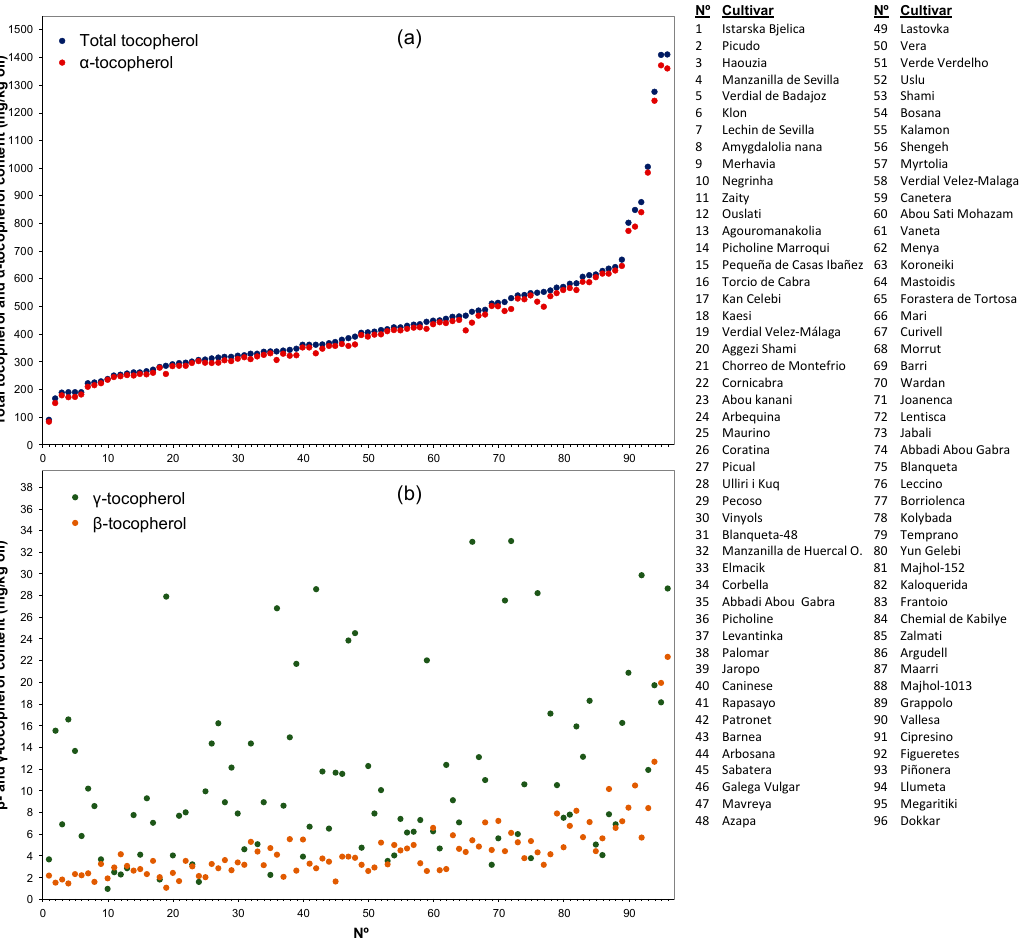
Figure 2. Content of tocopherols in the oils produced by 96 cultivars from the World Olive Germplasm Collection: ( a ) total tocopherol and α -tocopherol; ( b ) β - and γ –tocopherol. Olive fruits at turning stage were hand-picked over the crop years 2008–2017, processed for oil extraction in the same conditions and each sample analyzed twice for tocopherol content.